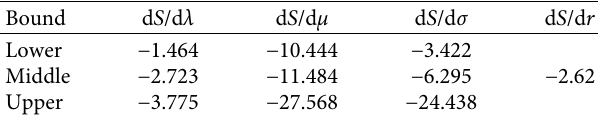
Table 1: Values of Greeks for 99% confdence intervals bounds.